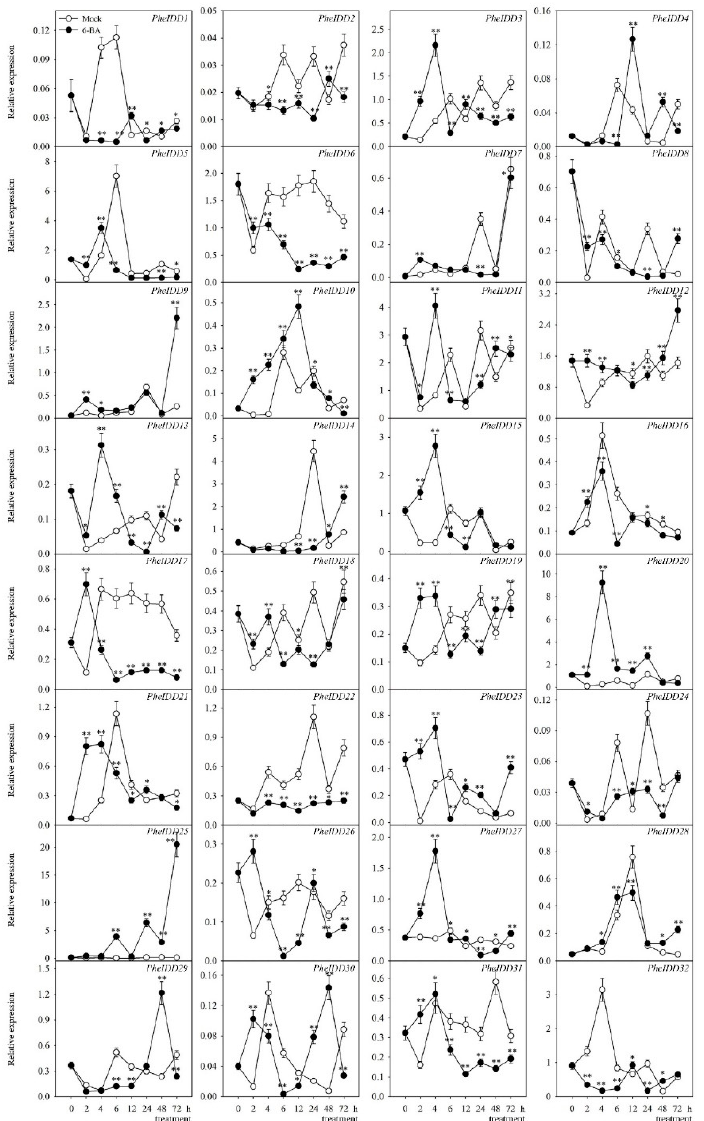
Figure 8. Expression patterns of PheIDD family genes under 6-BA treatment. Samples were harvested at 0, 2, 4, 6, 12, 24, 48, and 72 h after treatment. The PheNTB gene was used as a reference. The qRT–PCR results were obtained from three biological and three technical replicates. Five 0.6-cm sections of the stem base were harvested per replicate. Values are means ± SD. At a given time point, asterisks indicate a significant difference in expression between 6-BA treatment and Mock treatment based on LSD multiple comparisons. * p < 0.05; ** p <